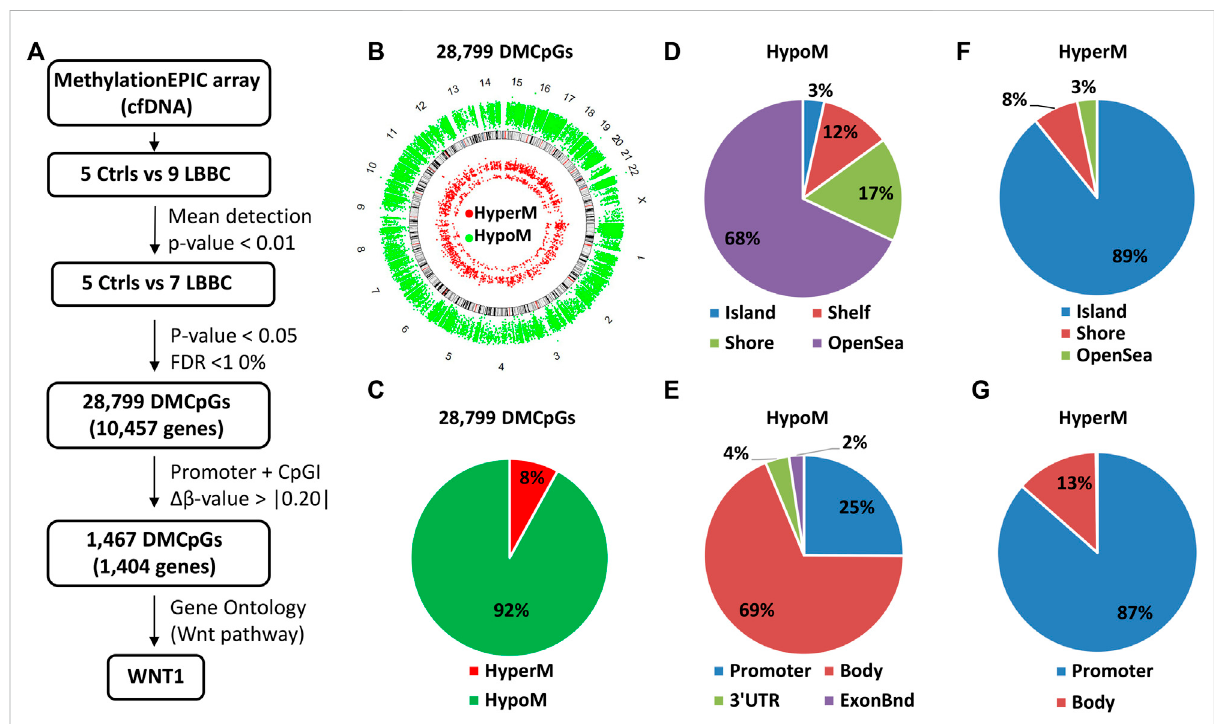
FIGURE 1 Methylation landscape of cell-free DNA in metastatic patients with luminal B breast cancer. (A) Flowchart of the cfDNA methylation analysis. Individual cfDNA samples from controls and luminal B breast cancer patients were analyzed with EPIC array. (B – G) Description of the 28,799 differentially methylated CpGs (DMCpGs) found in cfDNA of luminal B breast cancer patients according to (B) chromosome location, (C) methylation status, (D,F) CpG context, and (E,G) gene location. cfDNA, cell-free DNA; Ctrls, controls; LBBC, luminal B breast cancer; FDR, false discovery rate; HypoM, hypomethylated; HyperM,